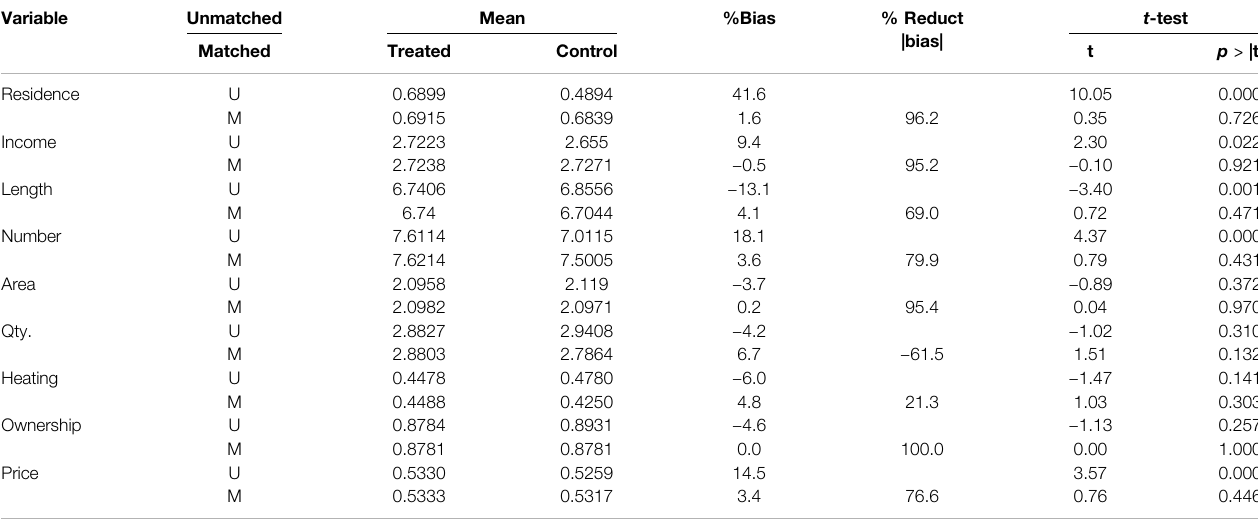
TABLE 5 | Test of equality of means of each variable before and after matching for electricity bills. Variable Unmatched Mean Matched Treated